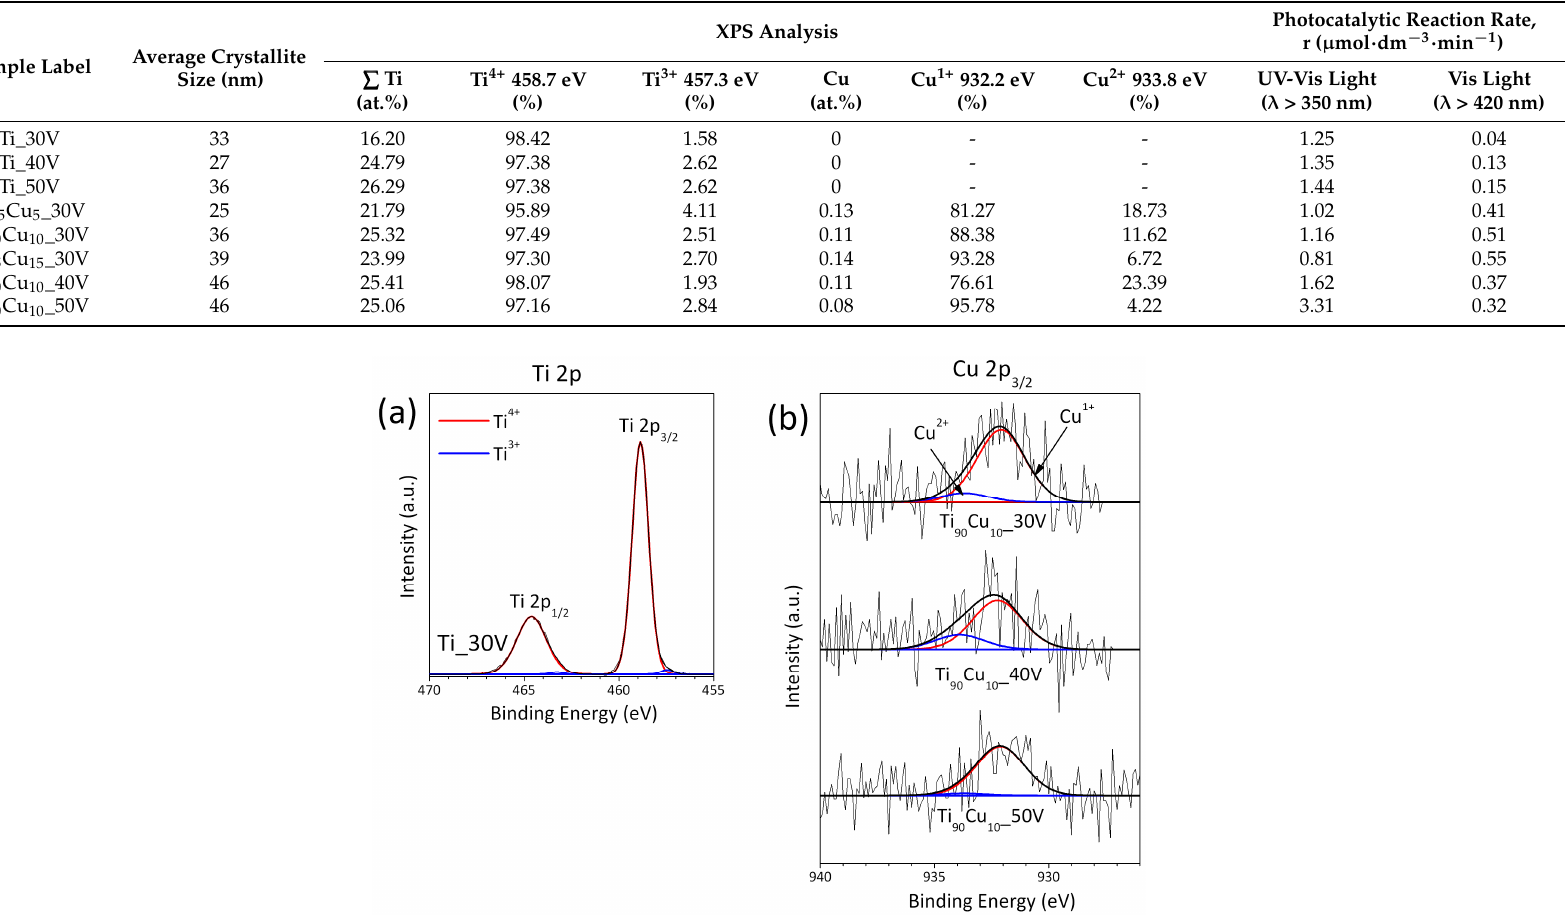
Figure 3. ( a ) Ti 2p XPS spectrum from the surface of pristine TiO 2 NTs (Ti_30V) and ( b ) Cu 2p 3/2 XPS spectra of selected TiO 2 /Cu x O y NTs (Ti 90 Cu 10 alloys anodized at 30–50 V).